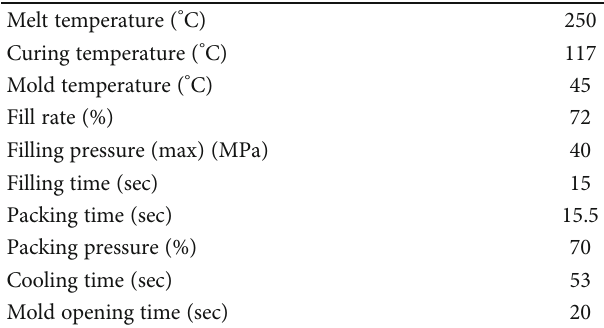
Figure 2: Recycled polypropylene viscosity and speci fi c heat. (a) Viscosity versus temperature and shear rate. (b) Speci fi c heat versus temperature. Table 2: Injection-molding parameters of recycled polypropylene.